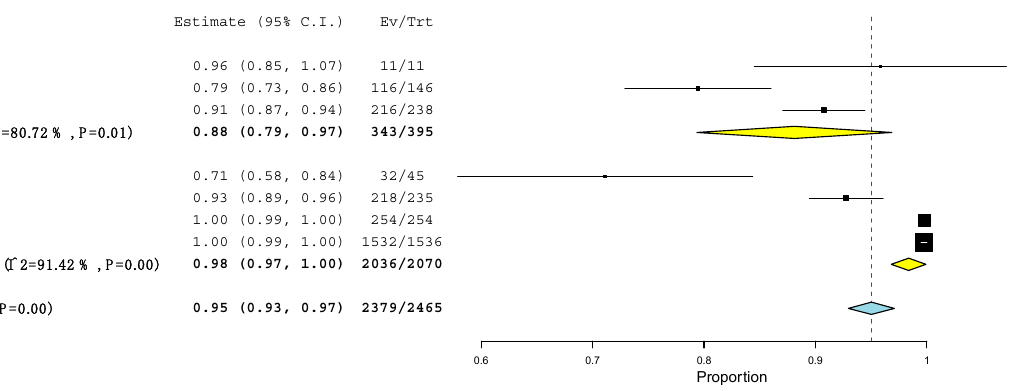
Figure 5. Sensitivity of 18 F-FES PET/CT at the level of the lesions across studies.